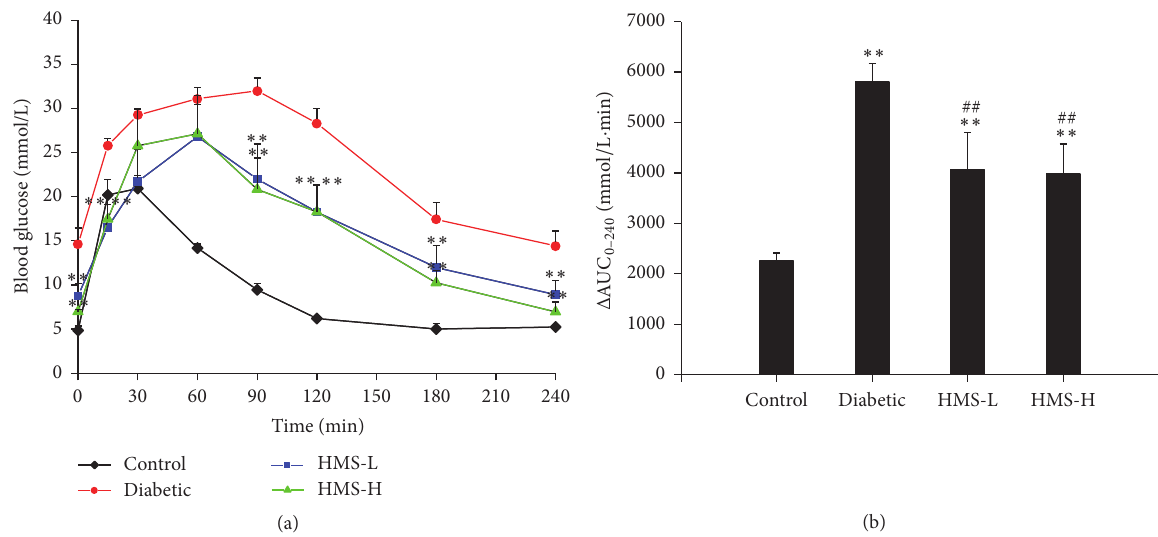
Figure 2: Effects of HMS5552 on the OGTT (a) and the Δ AUC 0 obtained from the OGTT (b). HMS-L group, low-dose (10mg/kg) – 240 min HMS5552-treated diabetic group; HMS-H group, high-dose (30mg/kg) HMS5552-treated diabetic group. The data are expressed as the mean ± SD ( 𝑛 = 6 ). ∗∗ 𝑃 < 0.01 , compared with the control group; ## 𝑃 < 0.01 , compared with the diabetic group.